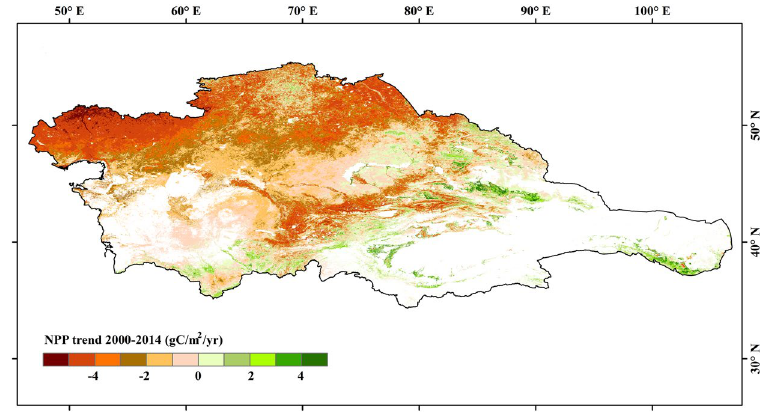
Figure 5. Spatial pattern of NPP trend during 2000–2014. (Generated by ArcGIS 10.2, URL: http://www.esri. com/software/arcgis/arcgis-for-desktop).